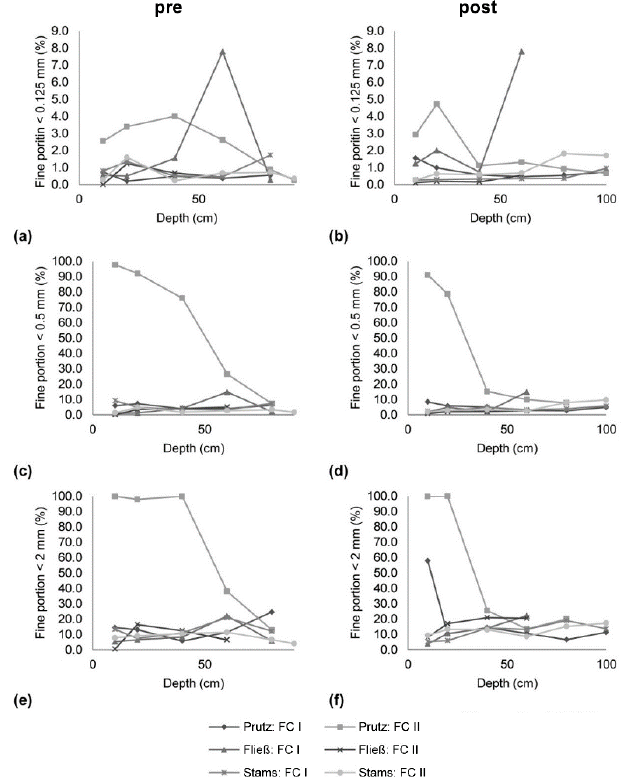
Figure 3. Comparison of fine sediment infiltration in the gravel matrix for the pre- and post-monitoring period; fines < 0.125 mm ( a ) pre- and ( b ) post-; fines < 0.250 mm ( c ) pre- and ( d ) post-; fines < 2 mm ( e ) pre- and ( f ) post-monitoring; reach 1 = Prutz, reach 2 = Fließ, reach 4 = Imst (compare to Figure 1).